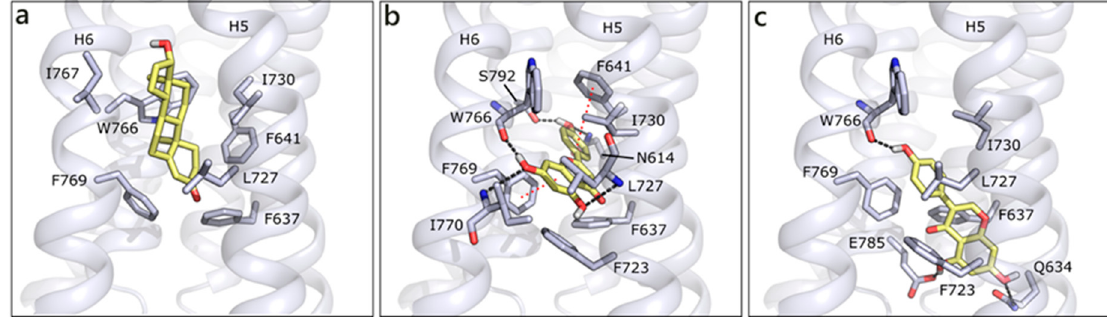
Figure 9. Docking poses of T ( a ), API ( b ), and GEN ( c ) in GPRC6A model. The protein is shown in grey cartoon, the residues lining the binding site and the ligands are shown in capped sticks and colored grey and yellow, respectively. Helices and residues lining the pocket are labelled, hydrogen bonds are displayed as black dashed lines.